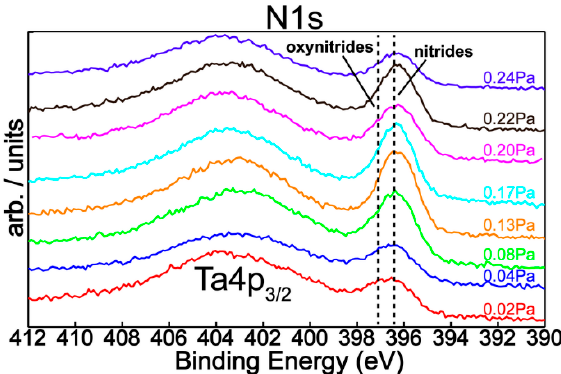
Figure 4. N1s XPS superimposed spectra for different reactive gas partial pressures.